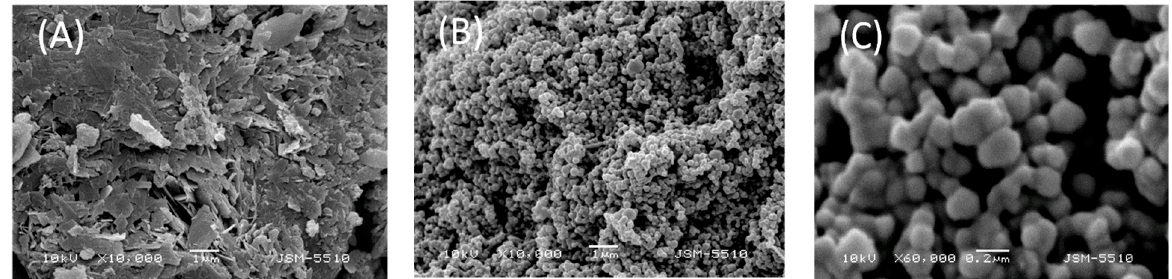
Figure 2. SEM micrographs of dendrimer D ( A ) and [Cu 8 (D)(NO 3 ) 16 ] ( B and C at different magnifications).